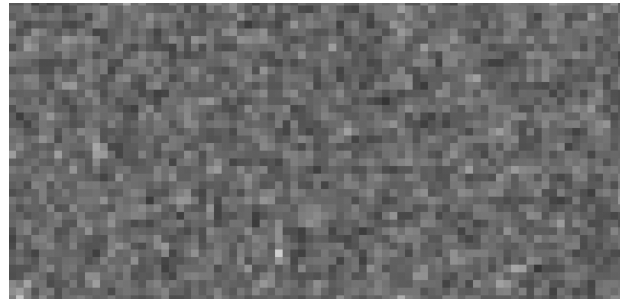
Fig. 9.— Zooming in on part of the background of figure 6 are several reasons that some of the pixels are brighter, others less bright. One is the presence of distant, un- resolved astronomical objects. But those cannot explain